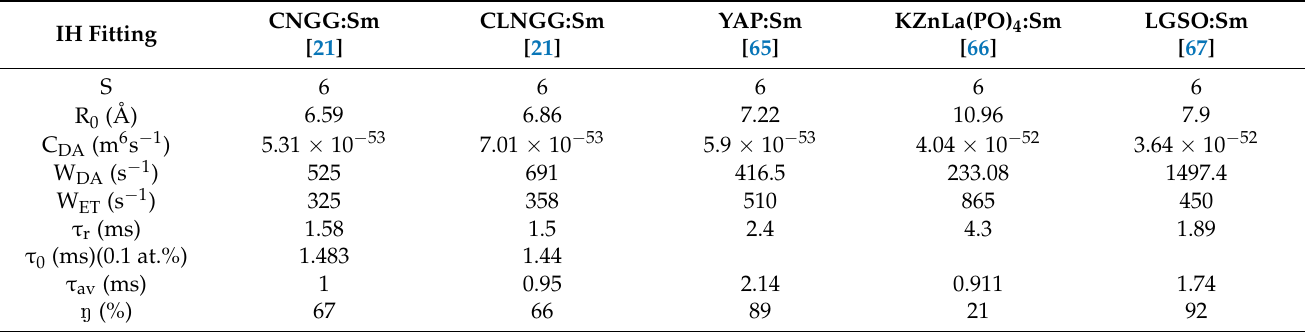
Figure 6. Emission kinetics of the 4 G 5/2 level of Sm 3+ ions in CNGG:Sm ( a ) and CLNGG:Sm ( b ), and the experimental transfer function ( c ). Table 6. Emission kinetic parameters of the 4 G 5/2 level of Sm 3+ ions in CNGG:Sm and CLNGG:Sm crystals.